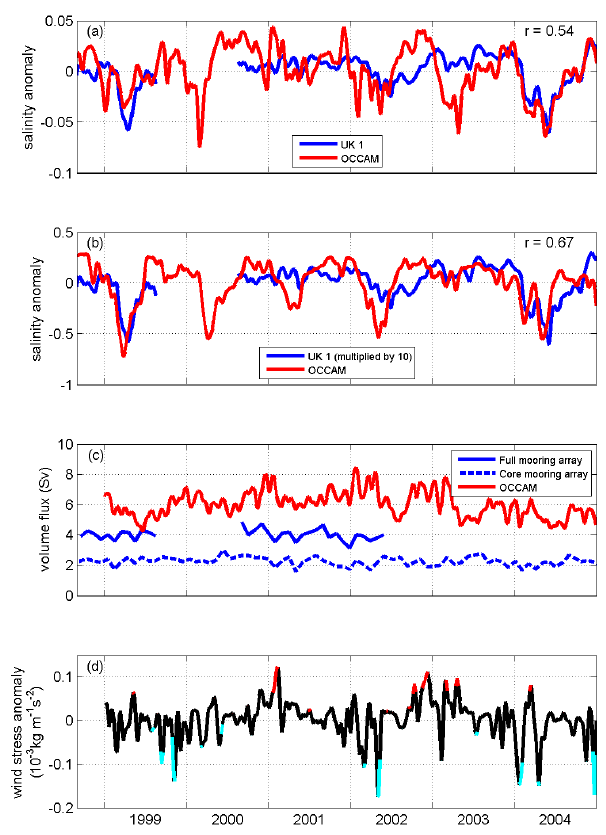
Fig. 5. (a) UK 1 (blue) and OCCAM (red) salinity anomaly time series. OCCAM time series taken from location marked ‘X’ in Fig. 2c. For the whole time series, the correlation coefficient r = 0.54; for 2004 only, r = 0.96 (p < 0.01). (b) UK 1 (blue) and OCCAM (red) salinity anomaly time series. OCCAM time series taken from location marked ‘+’ in Fig. 6. The maximum value of r = 0.67 (p < 0.01) occurs for a time lag of 6 weeks. UK 1 time series is multiplied by 10 to allow direct comparison of both time series. (c) Volume flux of the observed complete mooring array (F1, F2, UK1, UK2, G1, G2) and core mooring array (UK1, UK2, G1) for σ θ > 27 . 85 (solid blue and dashed blue line respectively) (from Fig. 19.7 of Dickson et al., 2008). Red line represents OCCAM volume flux calculated by integrating net transport for σ θ > 27 . 6 between the Greenland continental slope and 150km from point A (Fig. 2b). (d) NCAR meridional wind stress anomaly at the grid cell of highest correlation ( r = 0 . 53, p < 0 . 01) at 75 ◦ N 20 ◦ W in Fig. 10a. A time lag of 4.5 months has been applied to the time series. Seasonal cycle has been removed. For each calendar month, the three maximum (red) and minimum (cyan) wind stress anoma- lies over the 6 year period are used to composite salinity, velocity and sea surface